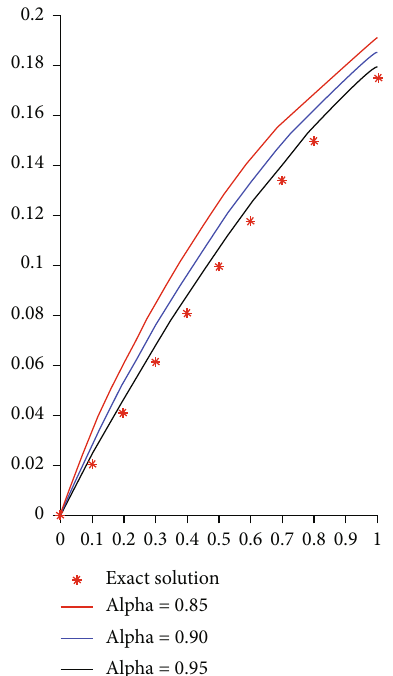
Figure 2: The solutions ψ ð x , t Þ = φ ð x , t Þ for equation (50) at di ff erent values of α and β t = π /2